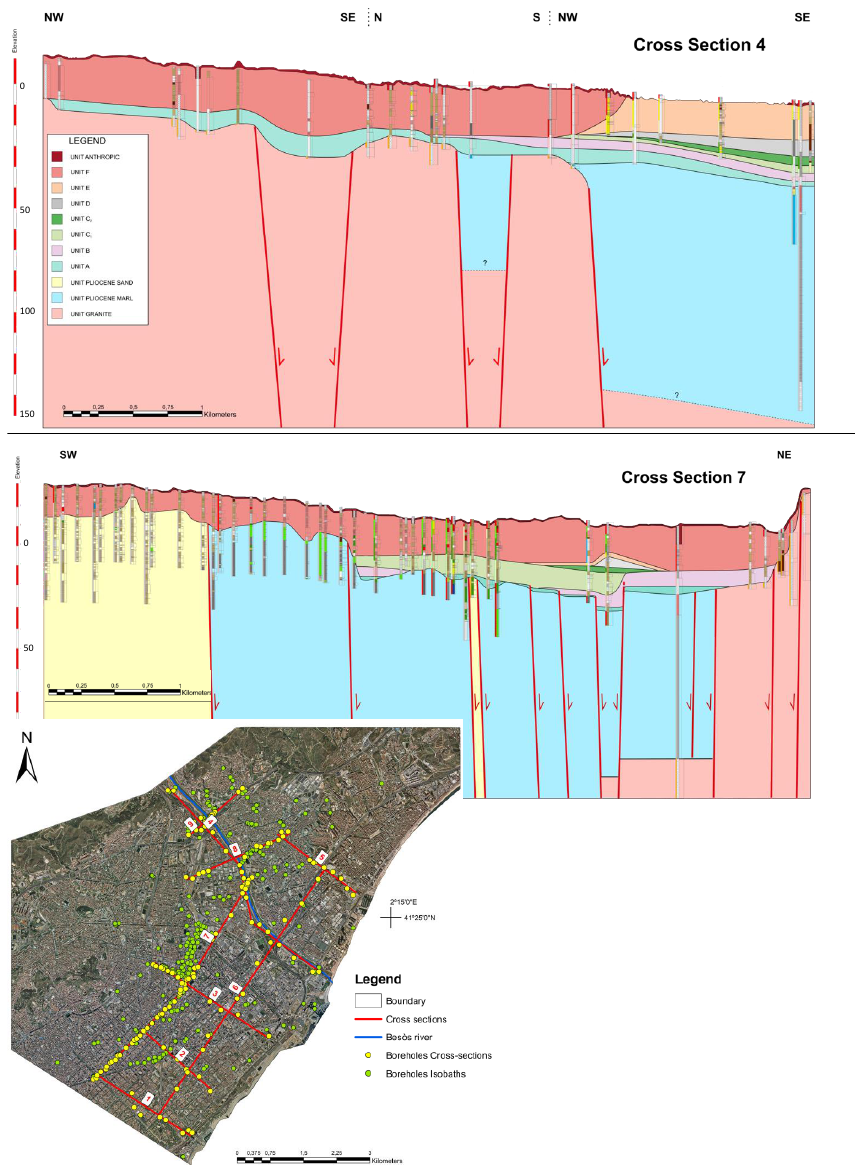
Figure 5. Sketch of geological cross sections 4 and 7. Bottom: plan view of the cross sections’ position. These cross sections were performed using HEROS tools (Velasco et al.,